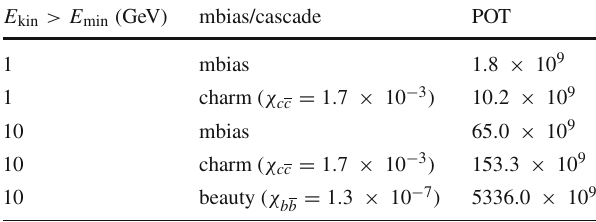
Table 1 Simulation samples made for SHiP background studies. χ is the fraction of protons that produce heavy flavour